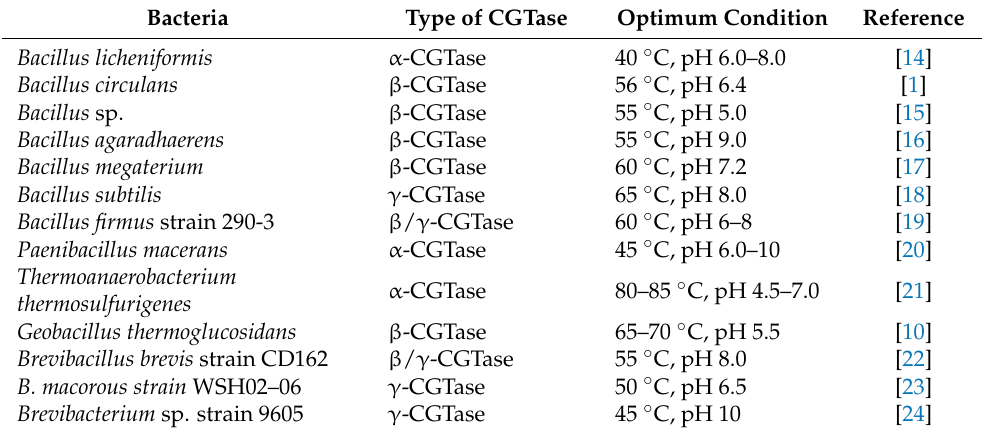
Table 1. Cyclodextrin glycosyltransferase (CGTase) sources and optimum growth conditions.